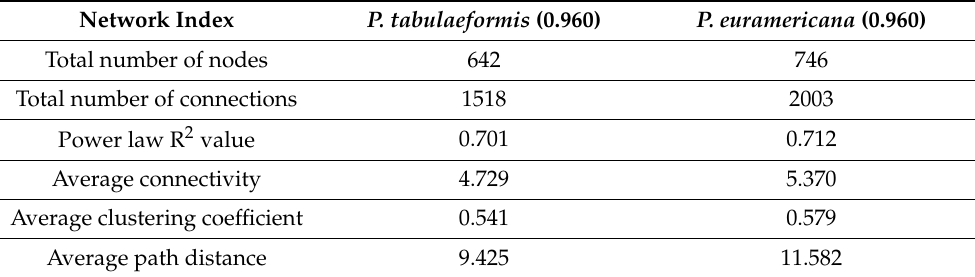
Table 2. Comparison of the topological properties of soil bacterial molecular ecological networks under the reclamation of P. tabulaeformis and P. euramericana .